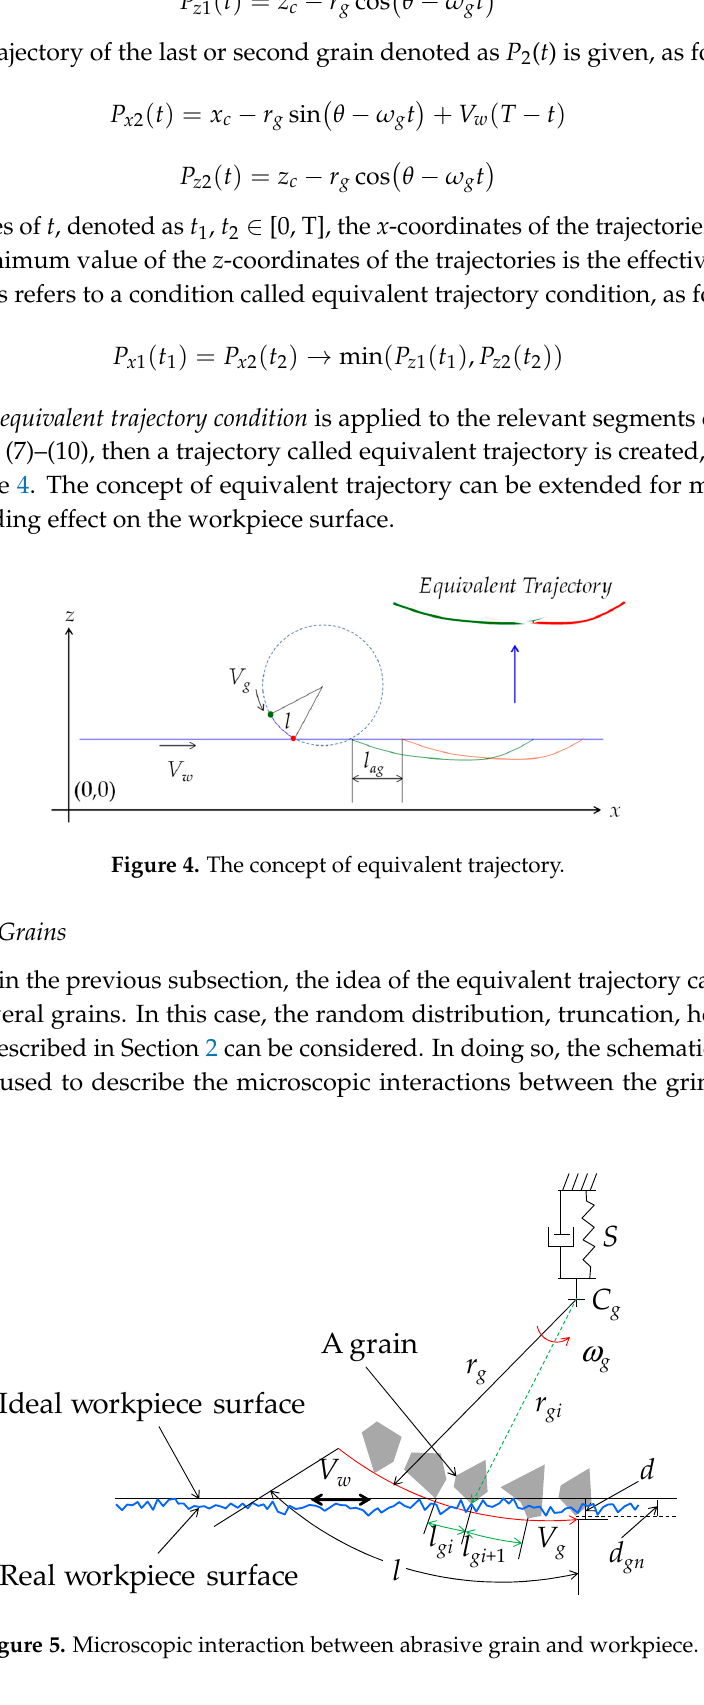
Figure 5. Microscopic interaction between abrasive grain and workpiece.